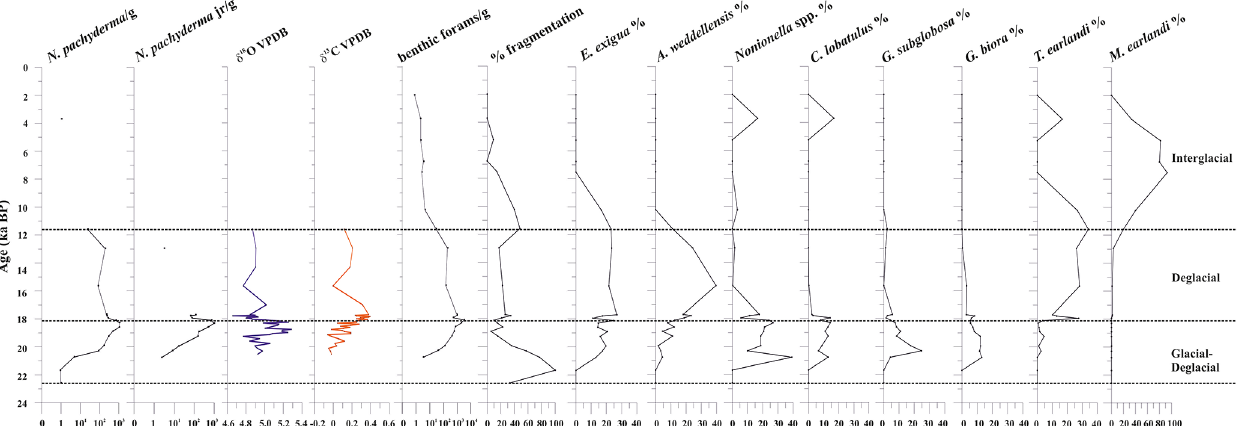
Figure 4. From left to right: down-core distribution of planktic (adult and juvenile forms) N. pachyderma (as the number of specimens per gram of dry sediment in logarithmic scale), stable oxygen and carbon isotopes on N. pachyderma , abundance (as the number of specimens per gram of dry sediment, logarithmic scale) of benthic foraminifera, fragmentation (%), and relative abundance (%) of benthic foraminifera. The top level of this core dates to